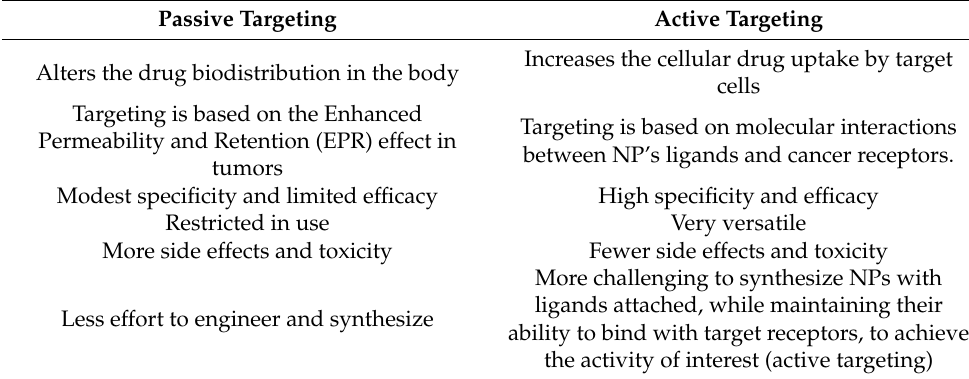
Table 2. Comparison between passive and active